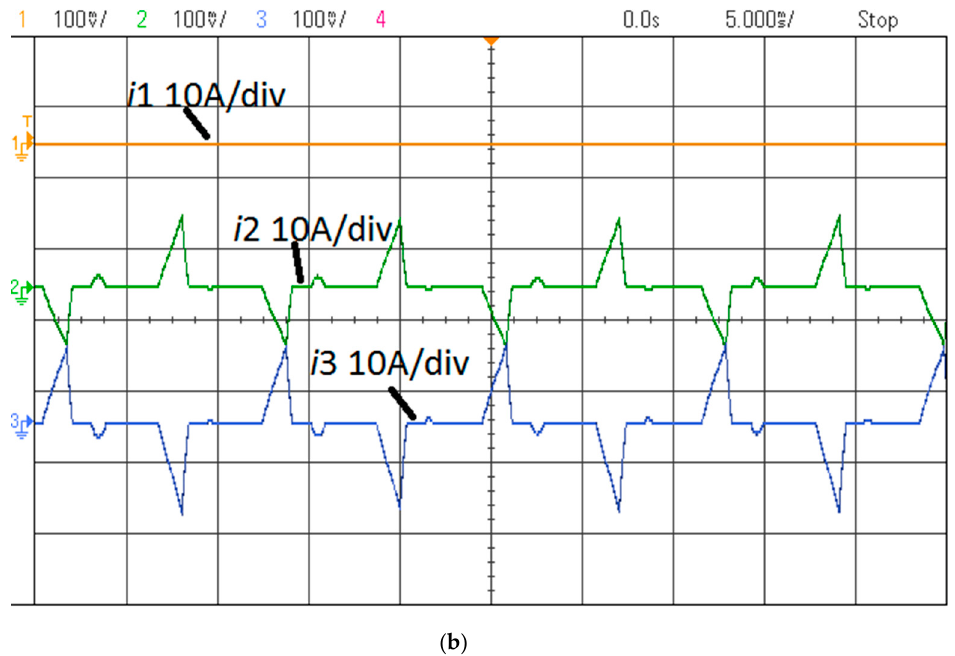
Figure 9. Waveforms of line currents in the star configuration with open OC1 switch: ( a ) numerical calculations; ( b ) measurements.